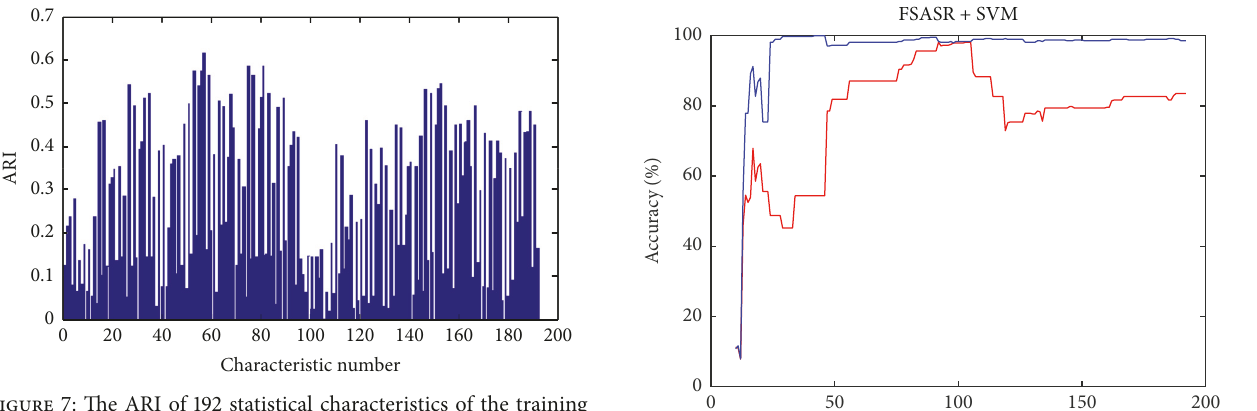
Figure 7: The ARI of 192 statistical characteristics of the training samples.